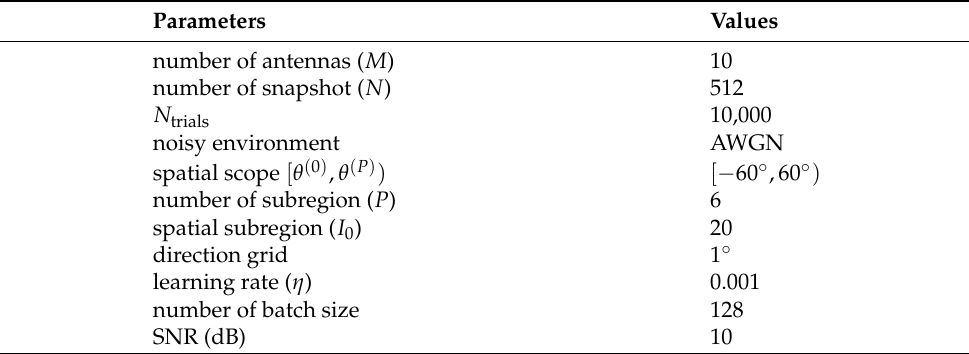
Table 1. Simulation